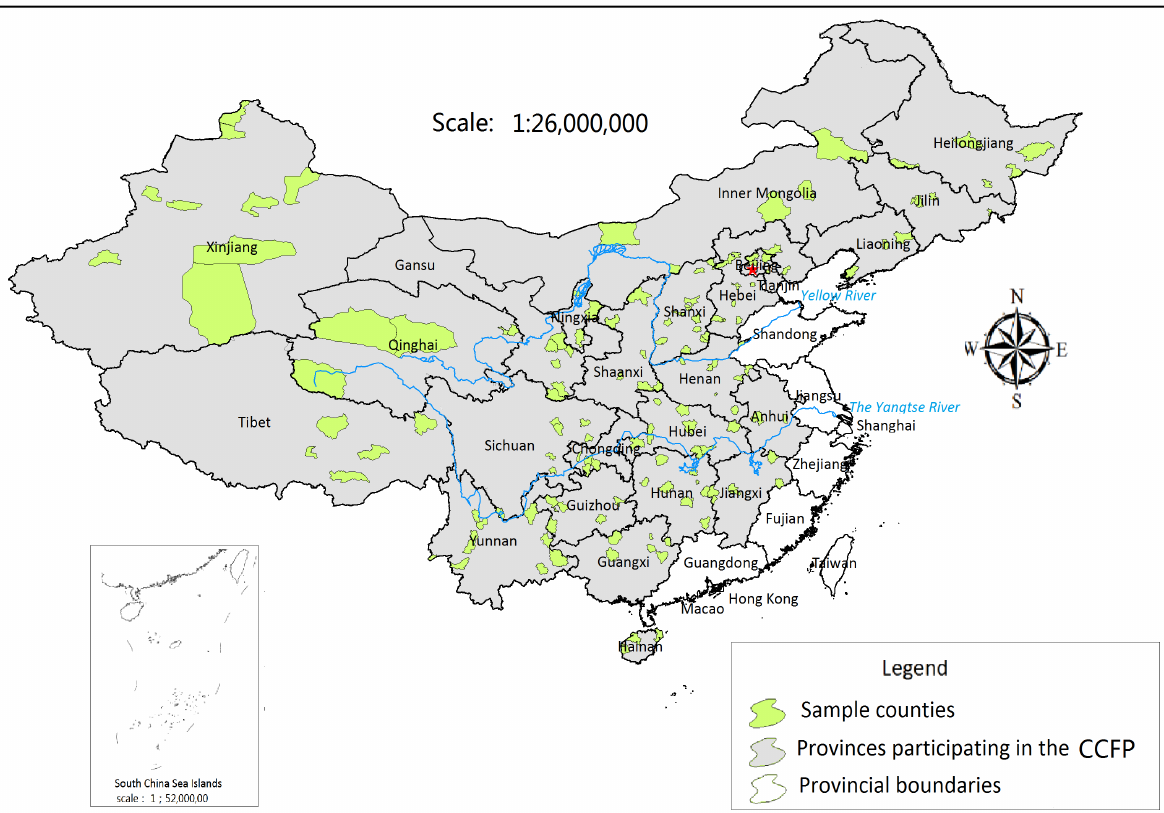
Figure 2. Conversion of cropland to forests program provincial coverage and survey data sample